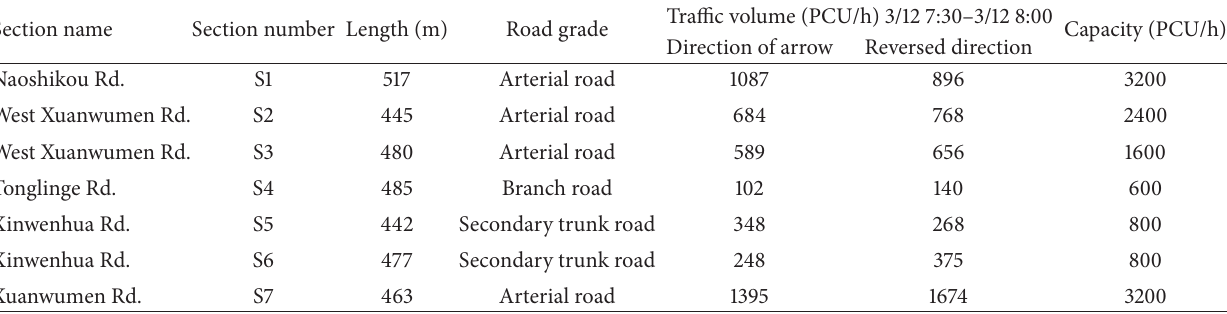
Table 3: Network parameters and